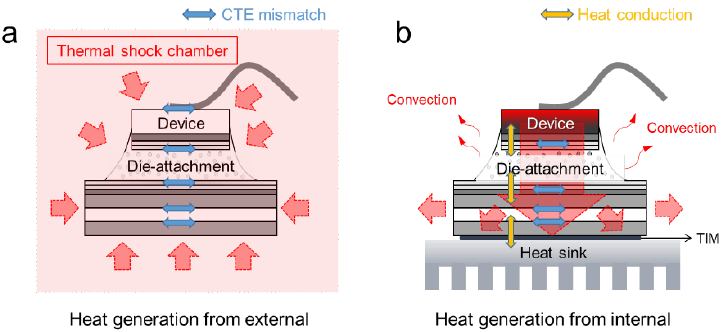
Figure 1. Comparison of the test environments and its heat transfer path: ( a ) thermal shock or aging condition as non-driving condition and ( b ) actual power cycling test as driving condition.